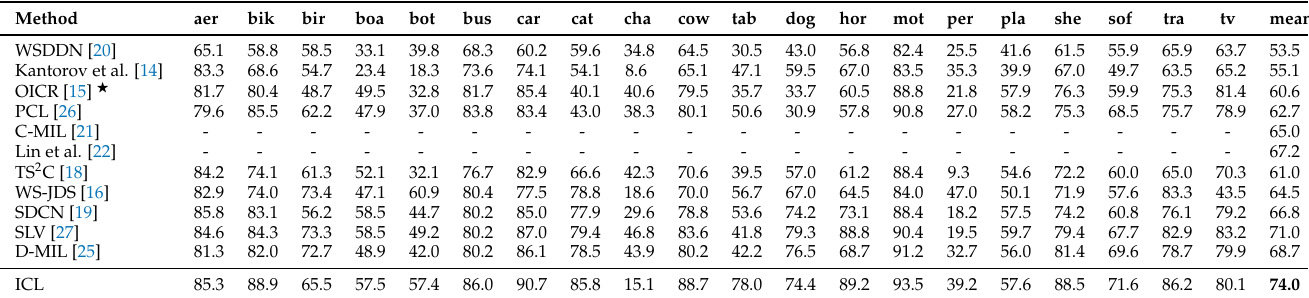
Table 2. Comparison with other methods on Pascal VOC2007 trainval set. (cid:70) means our baseline.